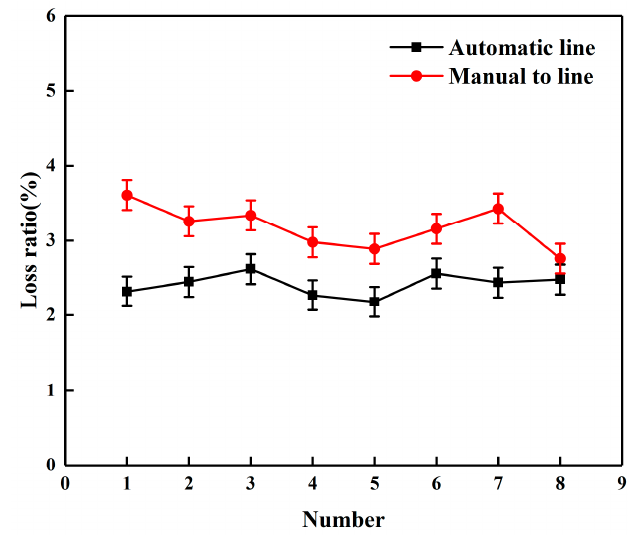
Figure 18. Corn kernels drop loss.